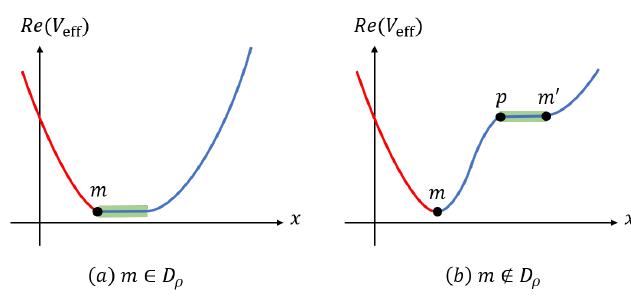
Figure 8. The real part of effective potential along a descent-ascent road parametrized by x . Red and blue curves are two different ascending roads γ ( m ) for a saddle point m of V eff . Green shaded region is (part of) the support of spectrum D ρ . In (a) m is one edge of D ρ and in (b) m is not on D ρ . In (b) the blue ascending road hits at a point p ∈ D ρ , then follows along D ρ to reach an edge m 0 of D ρ before extending to ∞